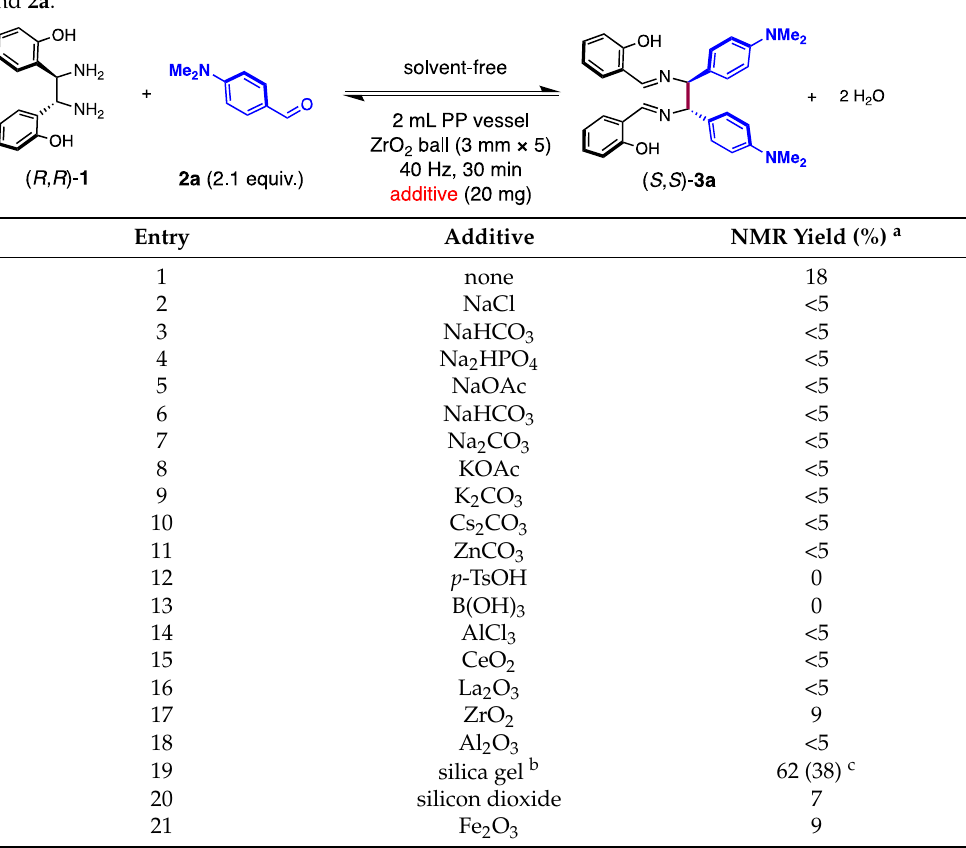
Table 1. Solid additive effect on mechanochemical DCR reaction between mother diamine ( R , R )- 1 and 2a .